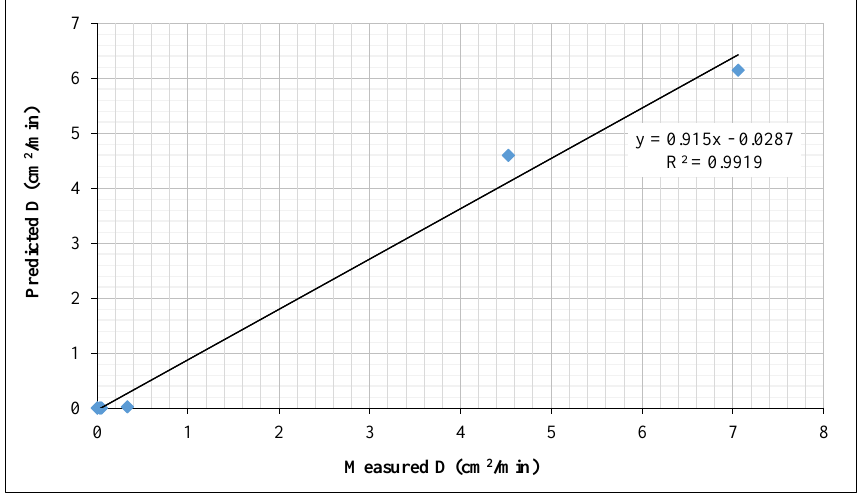
Figure 2. Verification of graph showing predicted and measured of dispersion in